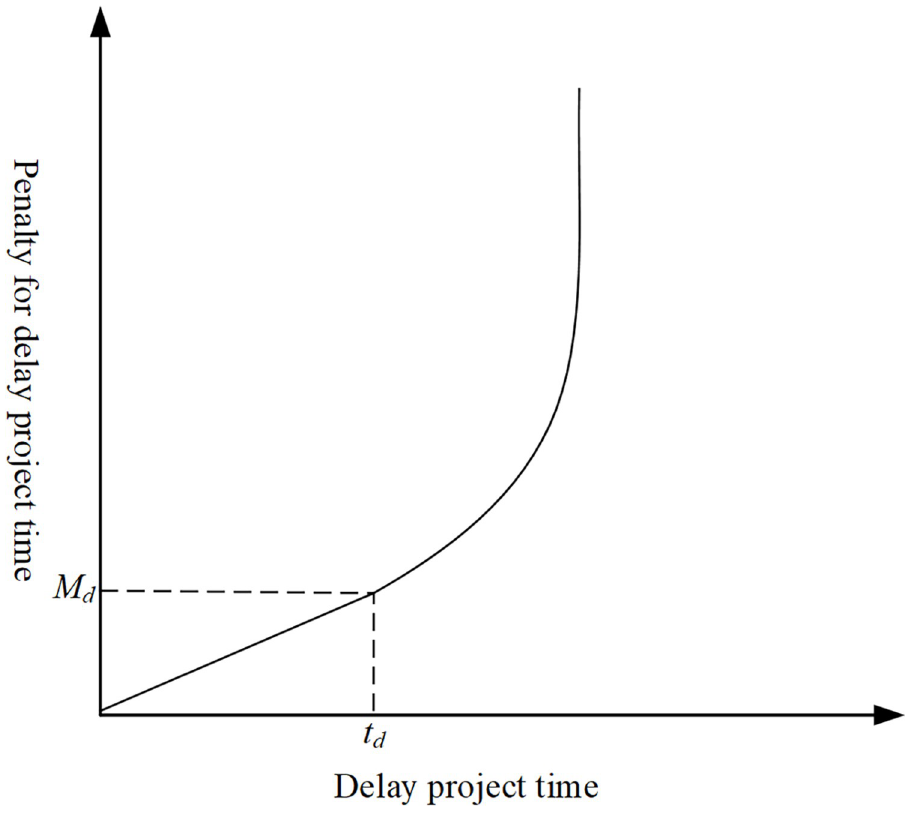
Fig 5. Penalty of duration delay